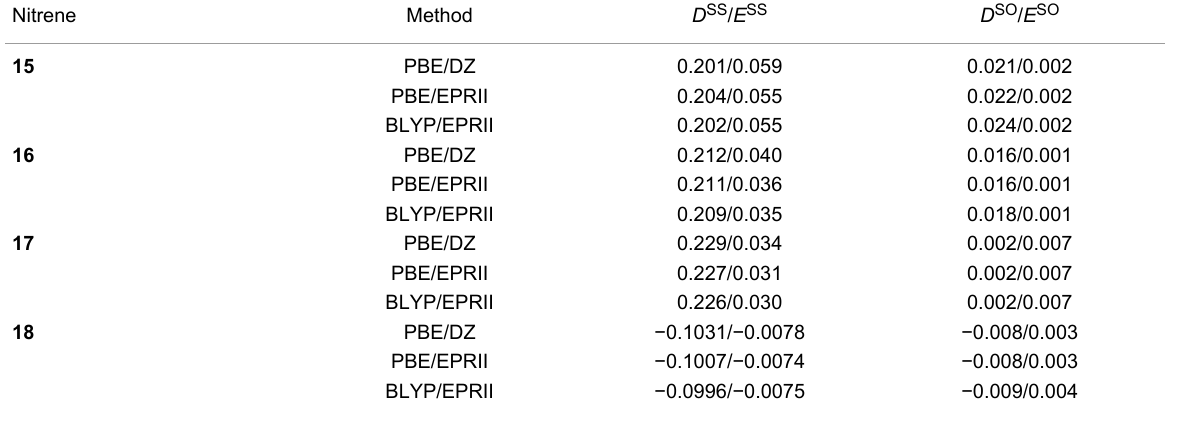
Table 3: DFT calculated parameters D SS / E SS and D SO / E SO in cm − 1 of nitrenes 15 – 18 .